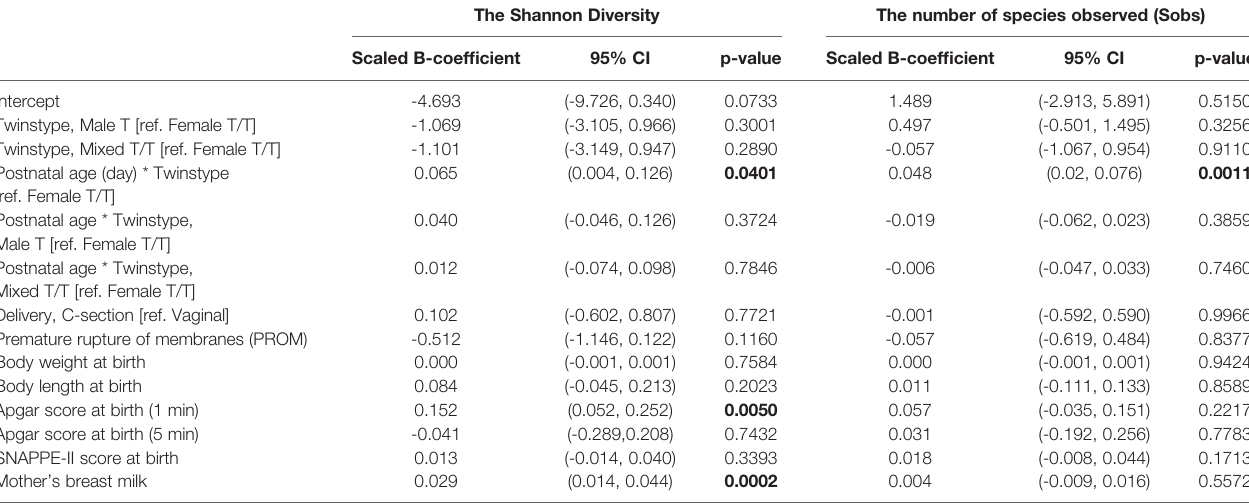
TABLE 3 | Factors associated with the Sobs and Shannon diversity indices, results from a linear mixed effect